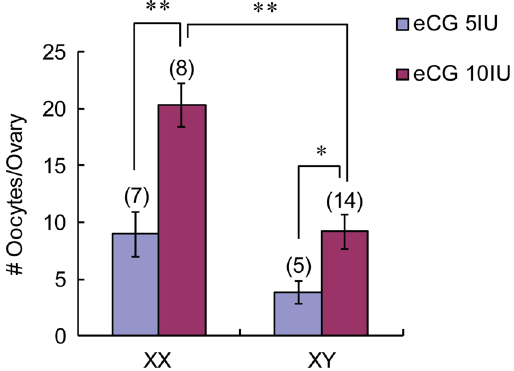
Figure 1. eCG-dosage dependent ovulation of oocytes from XX and XY females. The number of ovulated oocytes was larger after injection with 10 IU eCG than 5 IU eCG in both XX and XY females. The number of ovulated oocytes was also larger from XX females than XY females with 10 IU eCG. Data are presented as means ± SEM. The total number of females examined is given in parentheses at the top of each column. * and ** significant differences at p < 0.05 and 0.001,